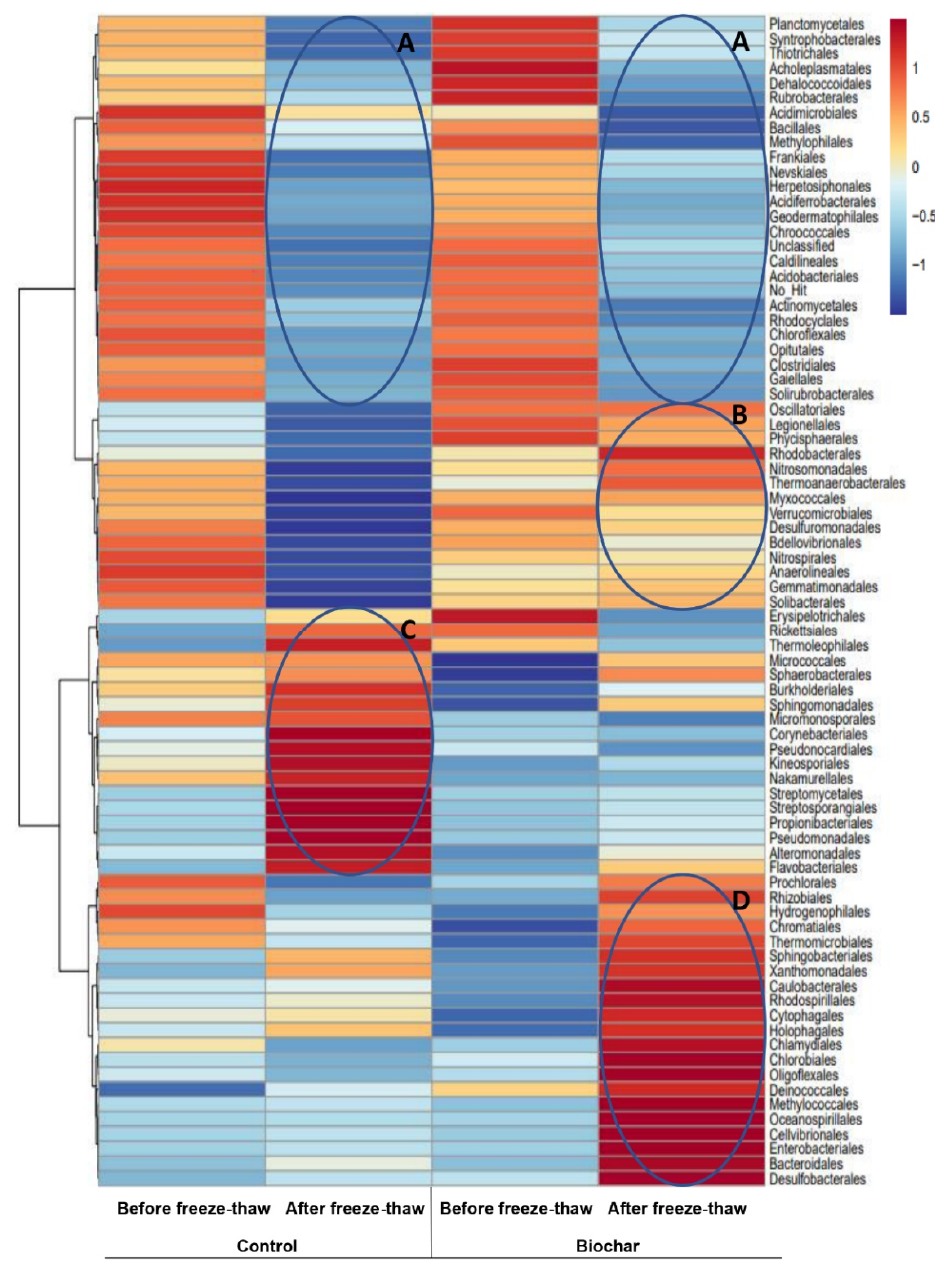
Figure 8. Heatmap presenting differences in relative abundance of particular sequences among all obtained sequneces between phytostabilized non−amended (control) and biochar−amended soil samples, respectively, (order level of microbial composition, Euclidean distance measure, Ward algorithm used for clustering); A, B, C, D indicate particular groups of microorganisms, for explanation see the text. Phytostabilization was carried out under the following conditions: (1) greenhouse temperatures (before freeze−thaw) and (2) greenhouse temperatures, followed by FT chamber temperatures (after freeze−thaw).